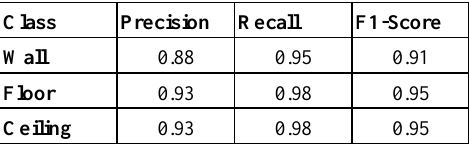
Table 3. Accuracy result of 1 st iteration (section